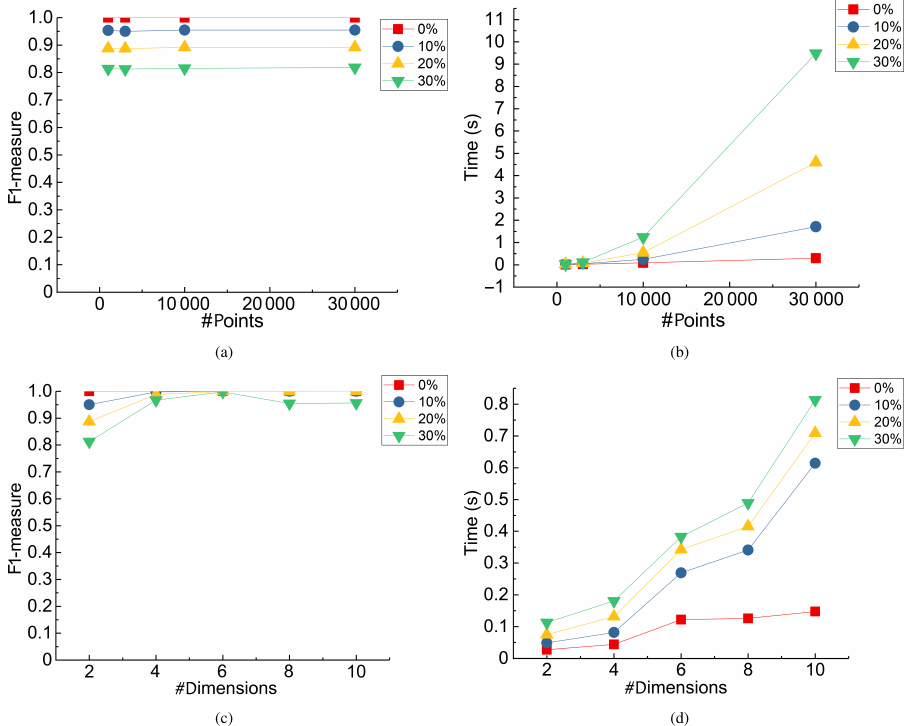
Fig. 7 Experimental results of CI-clustering with different missing rates (0%, 10%, 20%, and 30%).